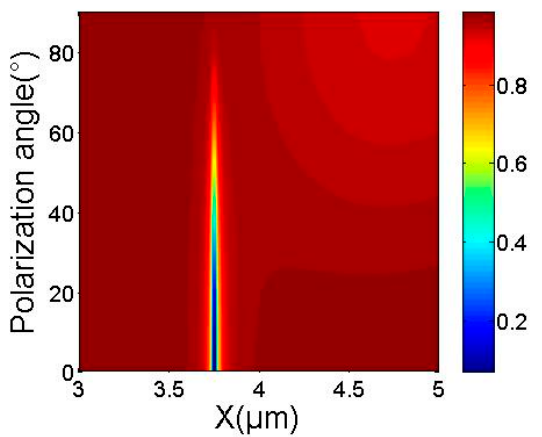
Figure 6. Parameters of the width of symmetrical Si grating ( A ) and thickness of symmetrical Si grating ( B ).